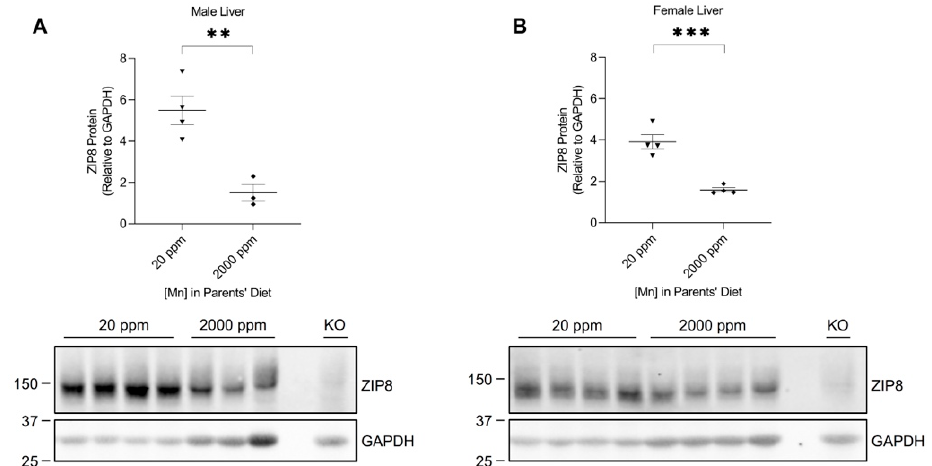
control. Quanti fi cation of ZIP8 levels were determined using GAPDH as the loading control. Data